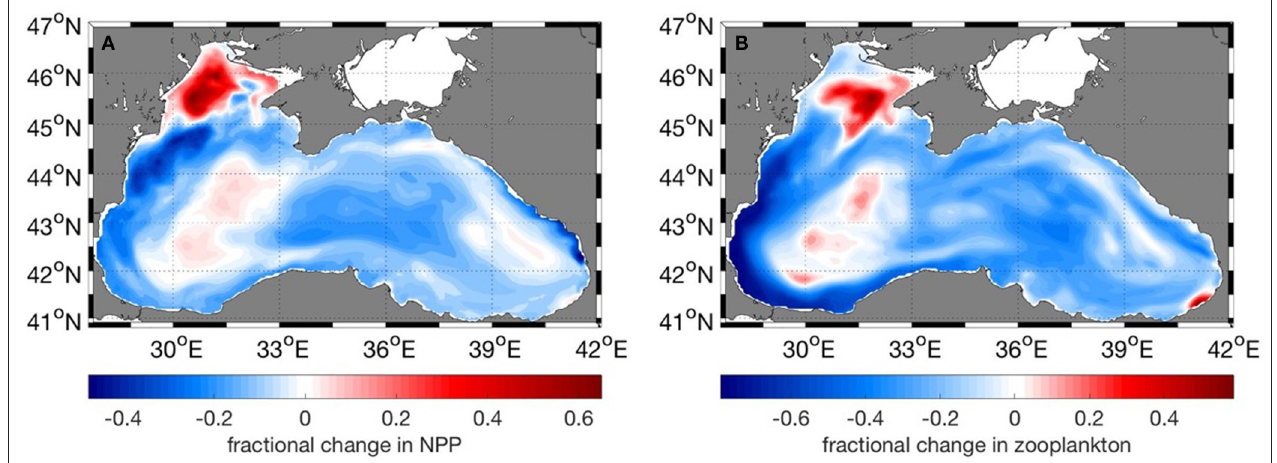
FIGURE 10 | Fractional change of (A) Net Primary Productivity, (B) Zooplankton biomass between the present (2010–2014) and future (2015–2020) periods. Negative values mean a decrease in the years 2015–2020.